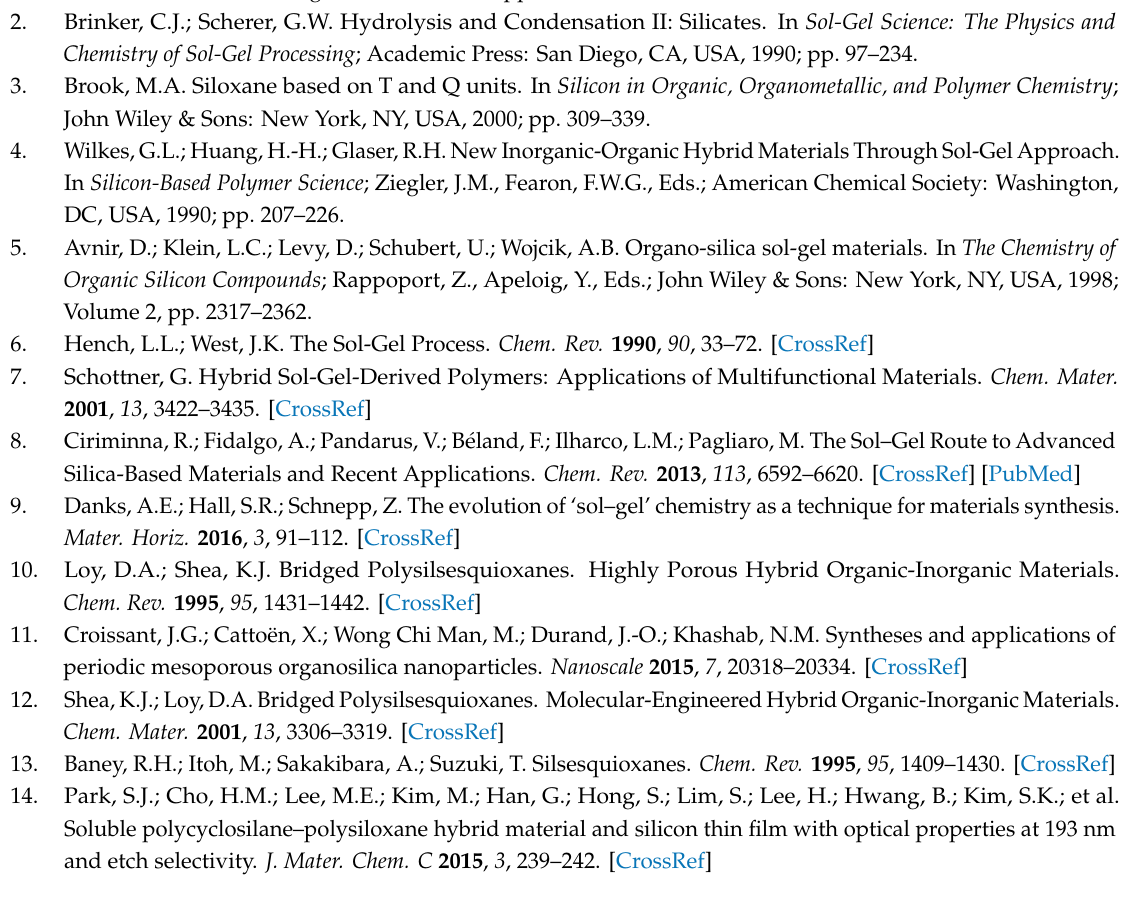
Figure S1: 1 H NMR spectrum of CPS, Figure S2: 29 Si NMR spectrum of CPS, Figure S3: HRMS result of CPS, Figure S4: 1 H NMR spectrum of NPS, Figure S5: 29 Si NMR spectrum of NPS, Figure S6: HRMS result of NPS, Figure S7: N 2 adsorption–desorption isotherms of the CPS xerogels. (a) CPSH, (b) CPSOH, (c) CPSN. Figure S8: Pore size distribution of the CPS xerogels. (a) CPSH, (b) CPSOH, (c)